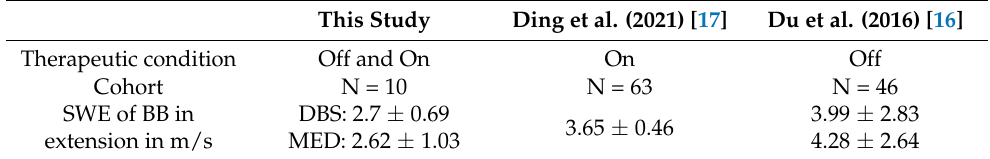
Table 4. Summary of muscle SWE reference values (SWV in m/s) sorted by the authors. This Study Therapeutic